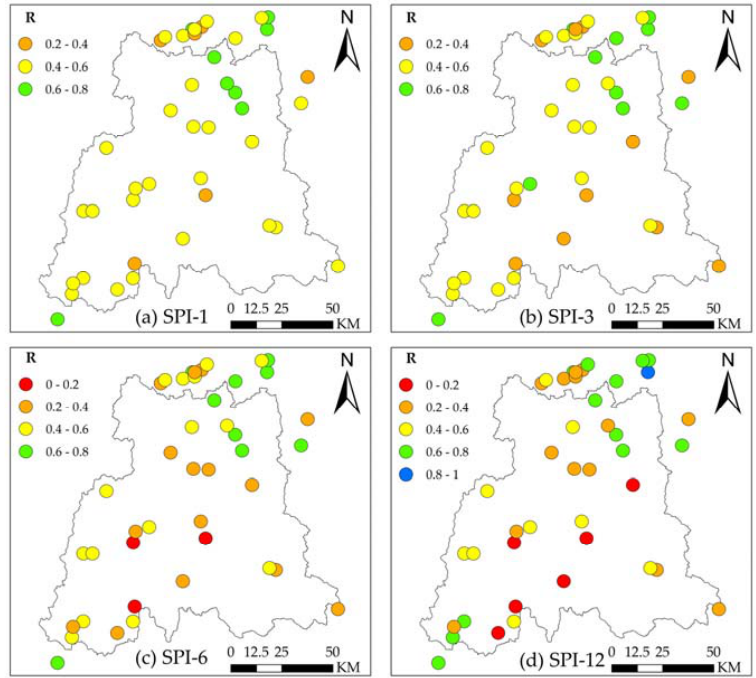
Figure 6. Pearson linear correlation coefficient (R) between SPI of the TMPA ‐ 3B43 and rain gauges at time ‐ scales of ( a ) one ‐ month; ( b ) three ‐ month; ( c ) six ‐ month and ( d ) twelve ‐ month in the Kelantan River Basin.